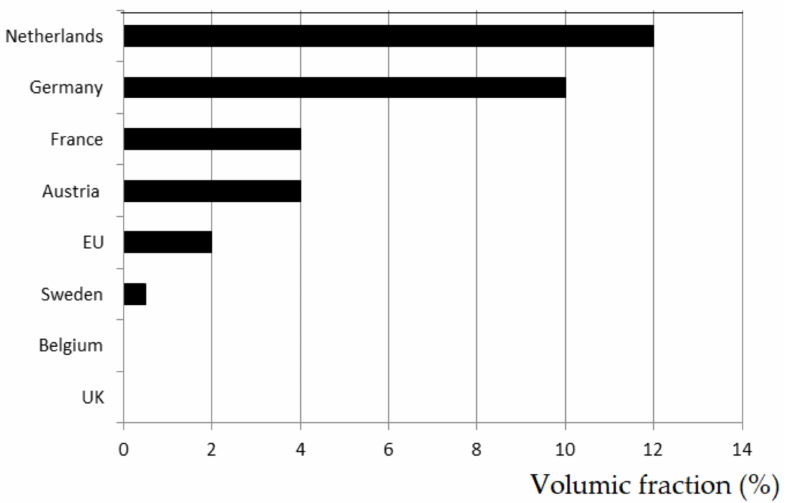
Figure 1. Variation between EU countries on maximum blend level of hydrogen in natural gas grid